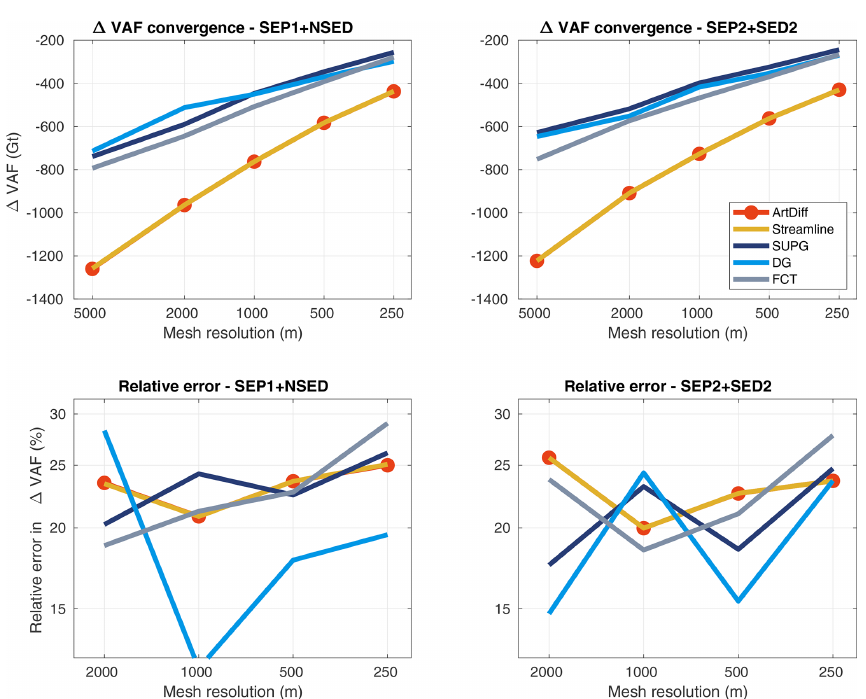
Figure 11. Basal melt experiment (melt on partly floating elements): convergence of (cid:49) VAF at the end of the experiment ( t = 100 years) for different stabilization schemes (see legend). Two sets of sub-element parameterizations are employed: SEP1 + NSED (left panels) and SEP2 + SED2 (right panels). The relative errors are computed using Eq. (45).